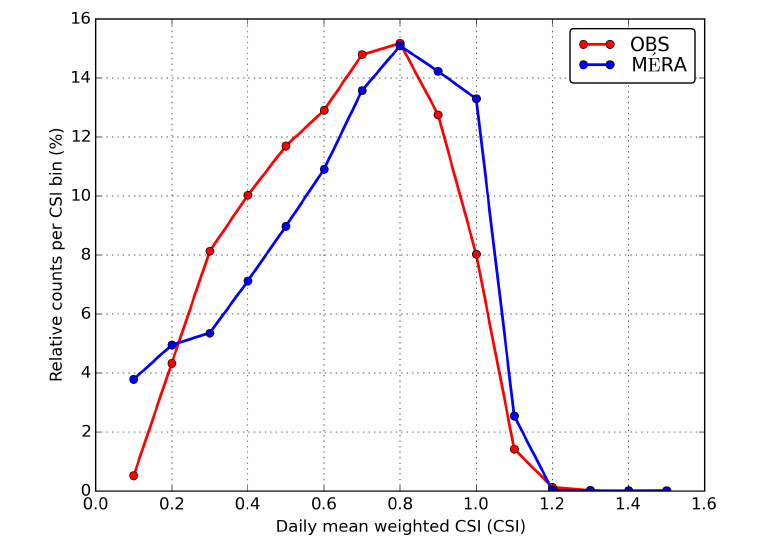
Figure 11. Frequency distribution of daily mean CSI (weighted using hourly SW irradiance) for observations and MÉRA data using data for the period 2008 to 2014.